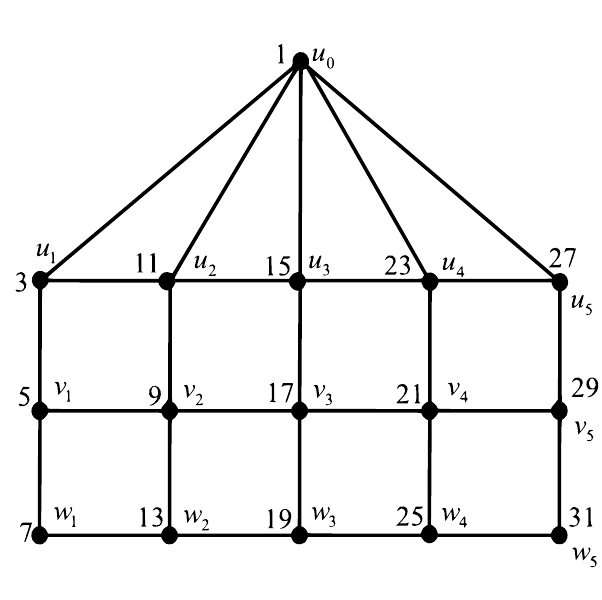
Figure 3: Arrow graph A 5